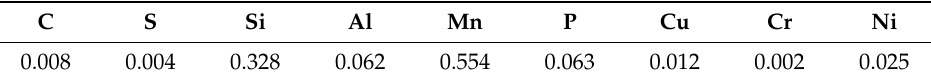
Table 1. Chemical composition of steel (wt.